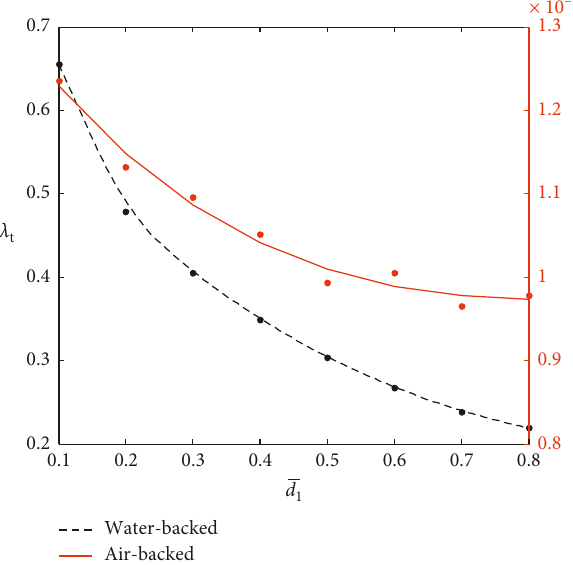
Figure 20: The absorbed energy for different outer shell thicknesses.